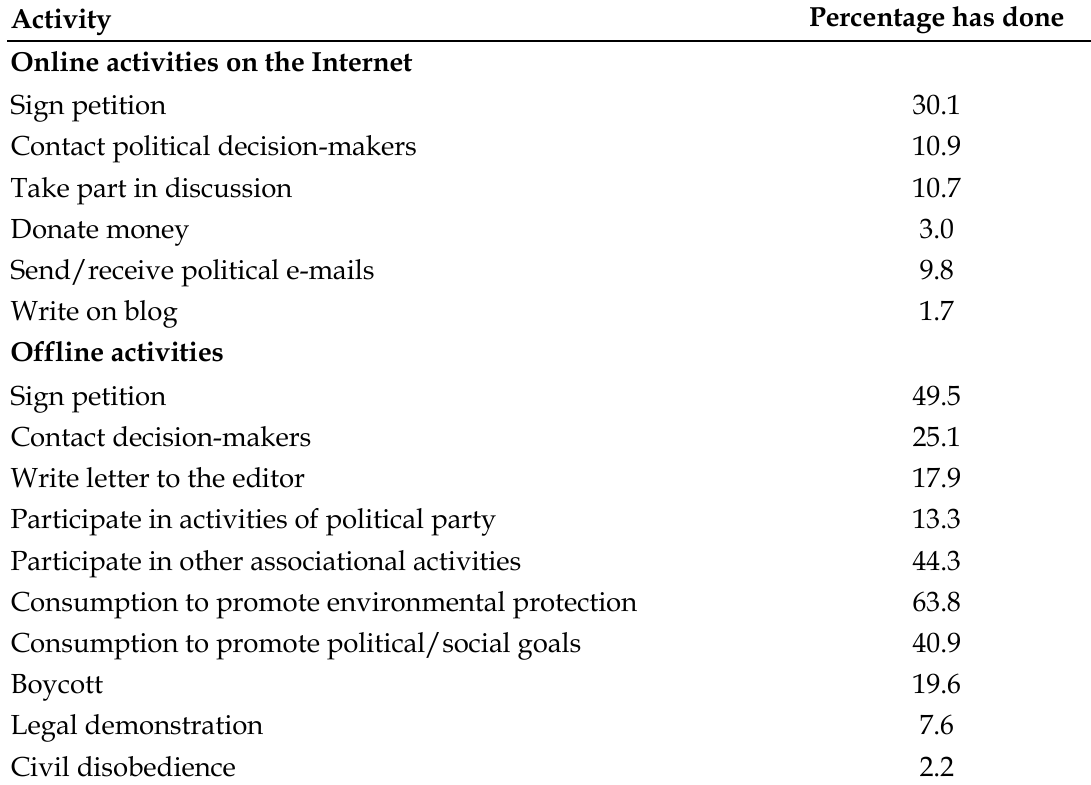
Table 2: Percentages performing online and offline forms of political activities